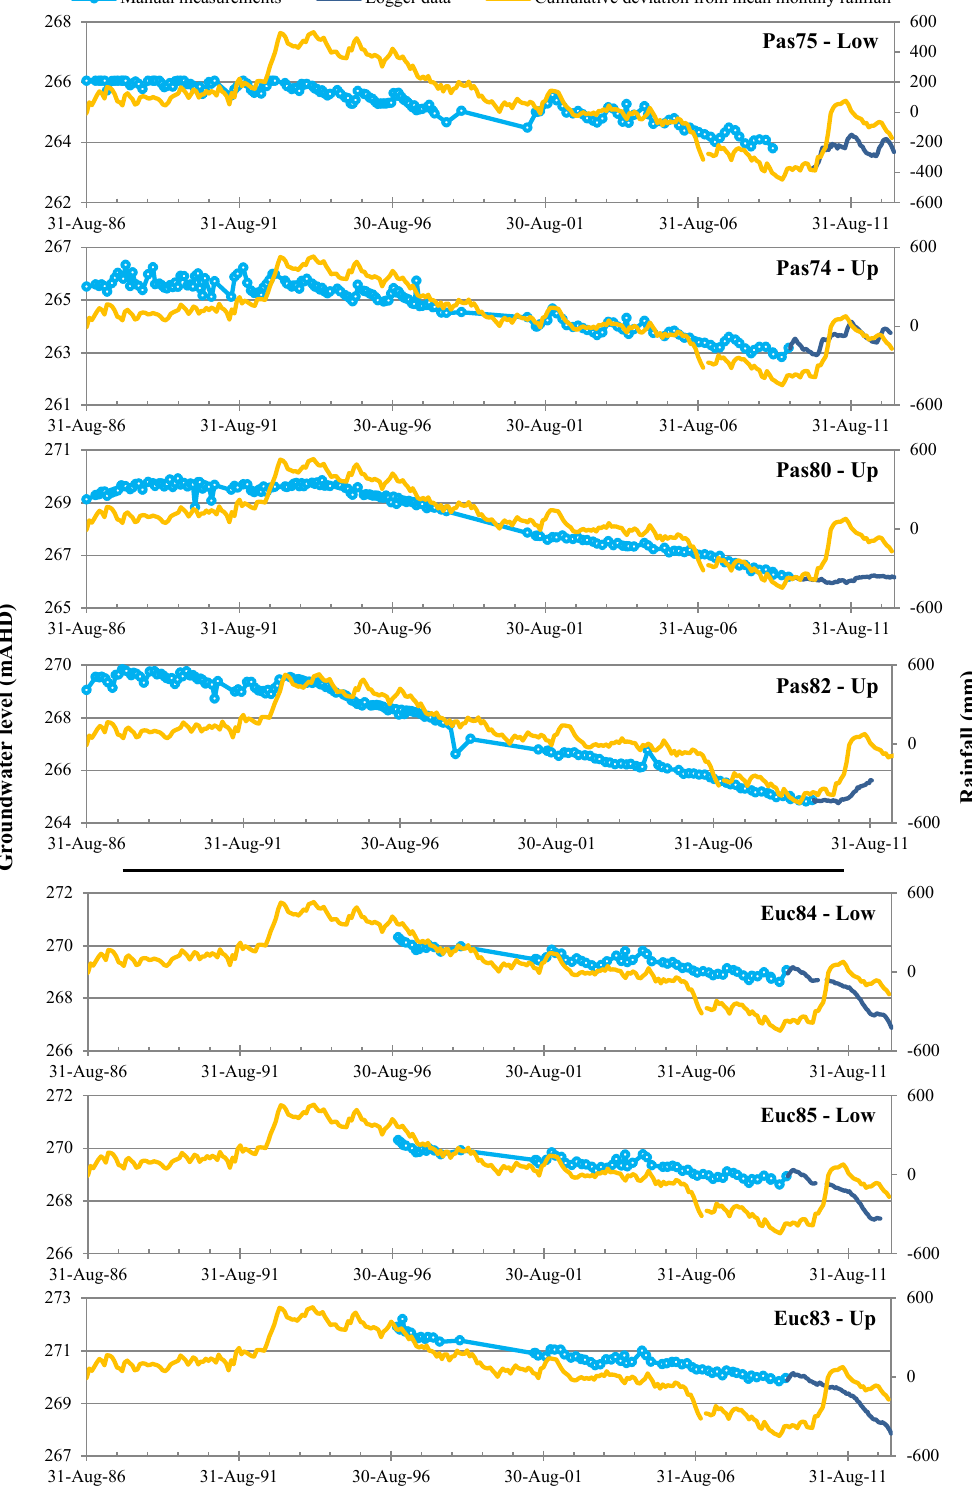
Figure 5. Long-term hydrographs for bores with available data and cumulative deviation from mean monthly rainfall to show the relationship between groundwater levels and long-term rainfall